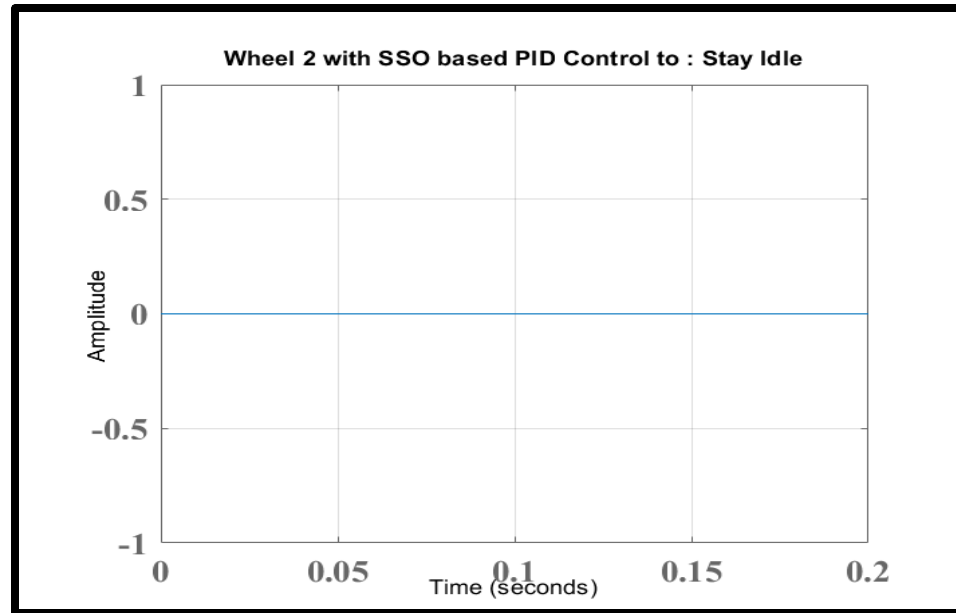
Figure 10. Simulation of wheel 2 when V r = V L .